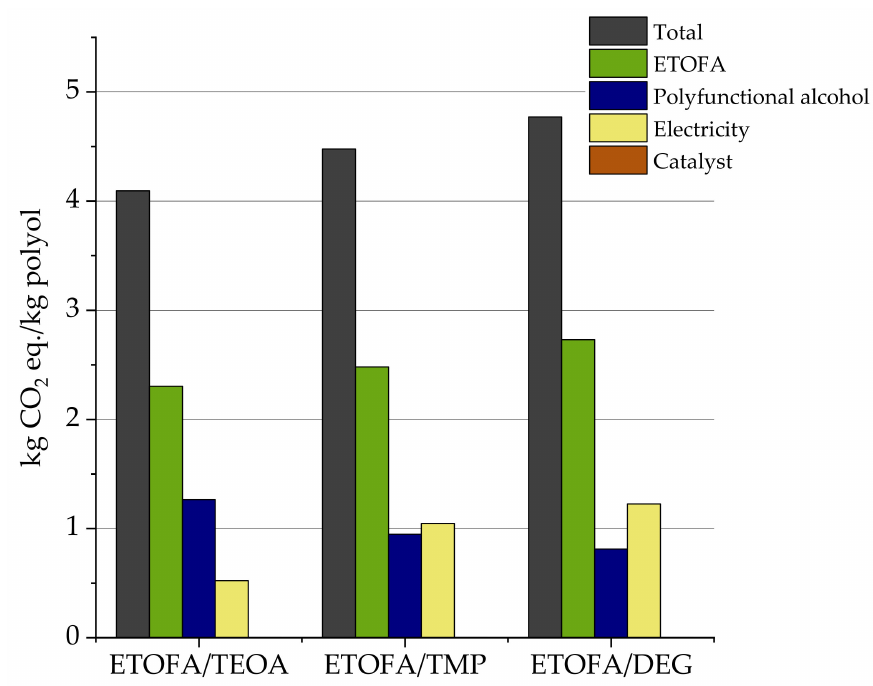
Figure 4. Balance of GHG emissions assigned to TOFA based bio-polyol production in total and per individual production